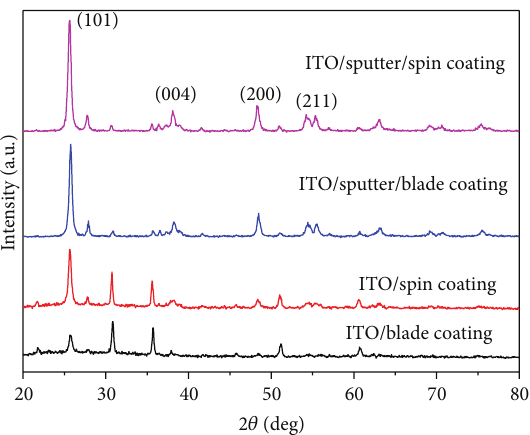
Figure 5: The XRD patterns for the TiO 2 films after being annealed at 450 ∘